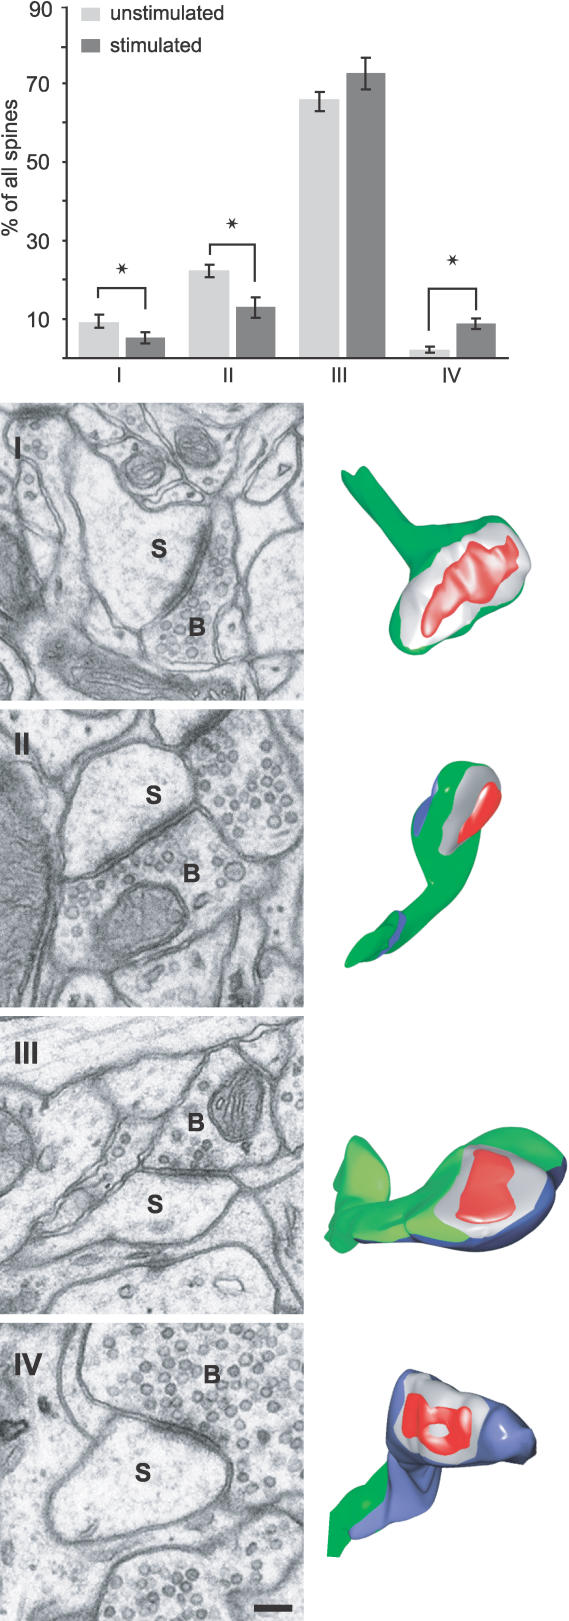
Sensory Stimulation Increases Percentage of Spines Whose Bouton–Spine Interface Is Surrounded by AstrocyteThe histogram shows the distribution of four classes of spines, sorted according to their degree of contact with the astrocyte (see examples of classes I–IV), expressed as mean ± standard error of the mean (SEM) (unstimulated, n = 6 mice; stimulated. n = 6 mice). The percentage of spines in class IV, whose bouton–spine interface is completely surrounded by an astrocytic element, was increased significantly in stimulated mice (p < 0.03). Dendritic spines were classified into four classes, I–IV, based on the arrangement of the astrocyte at their surface. Electron micrographs of spines of each class are shown, as well as the 3D reconstruction of the whole spine to the right. (spines are indicated with an S and axonal boutons, B). Examples of spines in classes I–IV, and their reconstructions, are shown. Scale bar in lower micrograph represents 200 nm.